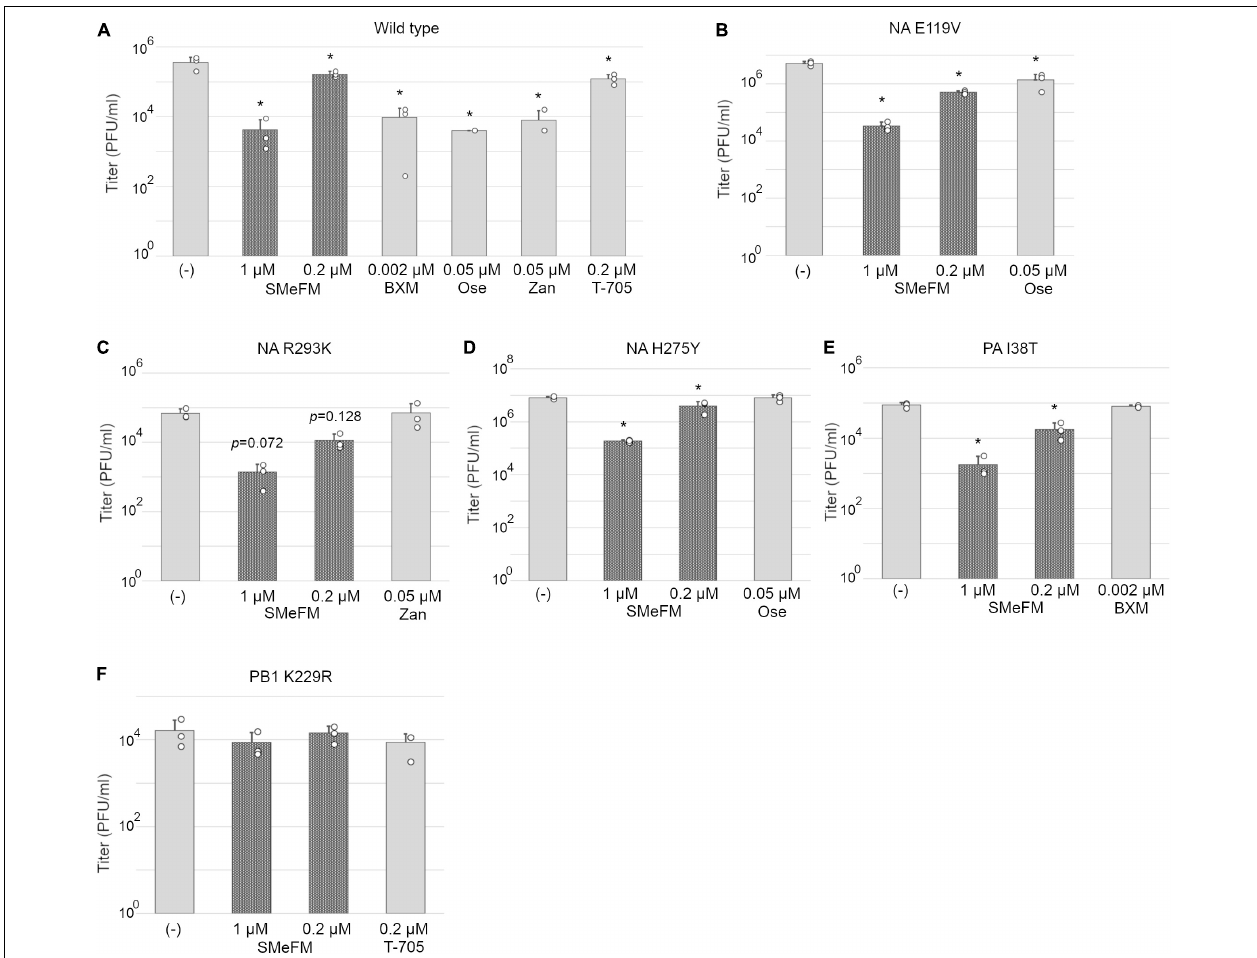
FIGURE 2 | PB1 K229R that reduces susceptibility to T-705 also reduces susceptibility to SMeFM. MDCK cells were infected with wild type (PR8 strain) (A) or mutant virus containing NA E119V (B) , NA R293K (C) , and H275Y (D) (N1 numbering; low susceptibility to neuraminidase inhibitors), PA I38T (E) (low susceptibility to baloxavir marboxil), or PB1 K229R (F) (low susceptibility to T-705) at an MOI of 0.01 and incubated with SMeFM or indicated compound for 24 h. The virus titer in the supernatant was determined by plaque assay. BXM: baloxavir marboxil, Ose: oseltamivir, and Zan: zanamivir. The graph indicates average values with standard deviations from three independent experiments. The circles indicate the titer of each experiment. P -values were calculated by Dunnett’s multiple comparison test. An asterisk indicates P -value less than 0.05.